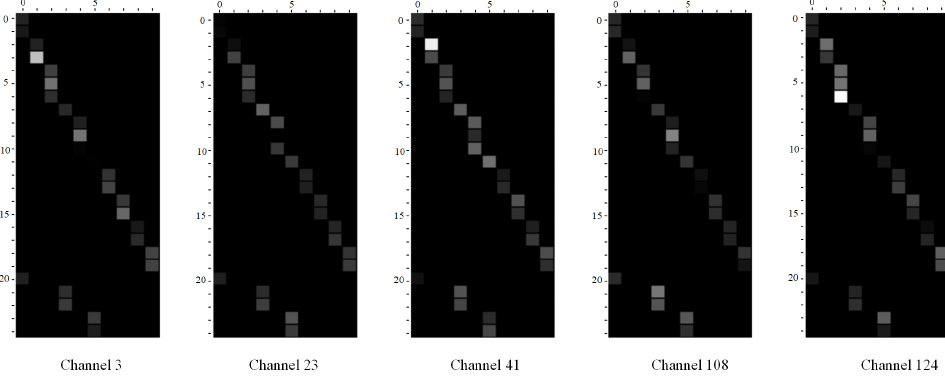
Figure 5. The Visualization of merging weights in CAMM. The horizontal coordinate is the in- dex of output vertices, and the vertical coordinate is the index of input vertices. The channel is chosen